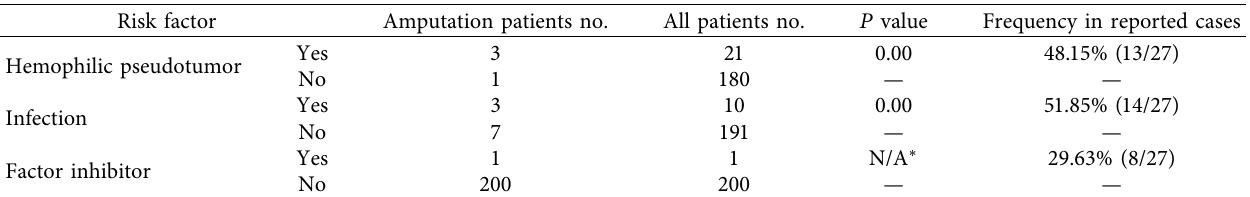
Table 2: Risk factors summarized from amputation patients’ records and their preferences in reported cases.